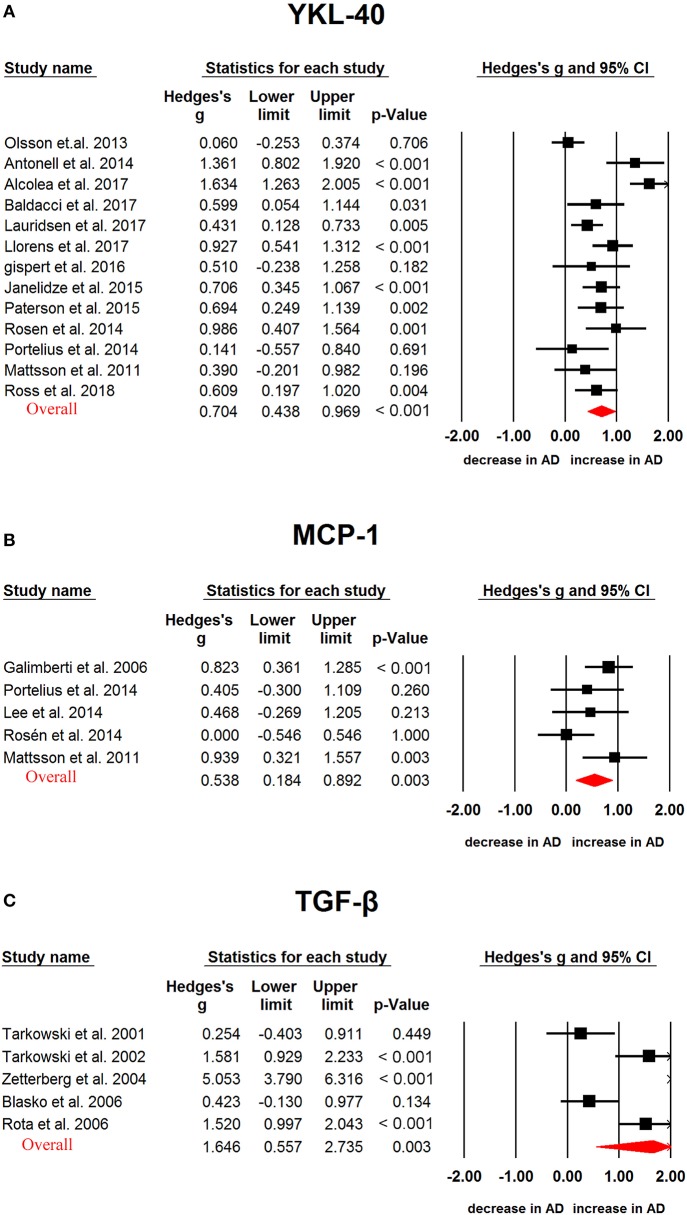
Studies of cerebrospinal fluid YKL-40, MCP-1 and TGF-β in Alzheimer's disease. Forest plot displaying random-effects meta-analysis results of the association between YKL-40 (A), MCP-1 (B), TGF-β (C) and Alzheimer's disease. The sizes of the squares are proportional to study weights.